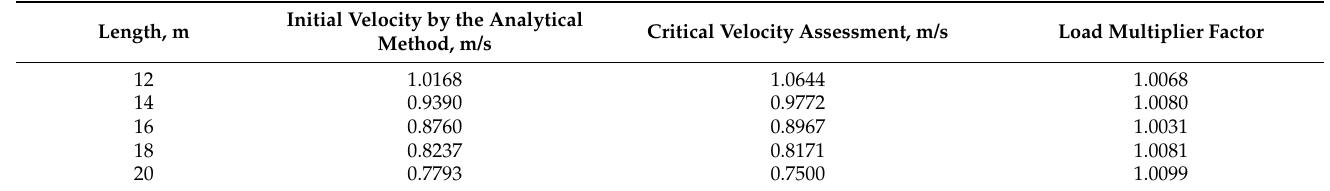
Table 2. The effect of the upper and lower cage pipe length (and width) on the critical velocity, for the Drift State.